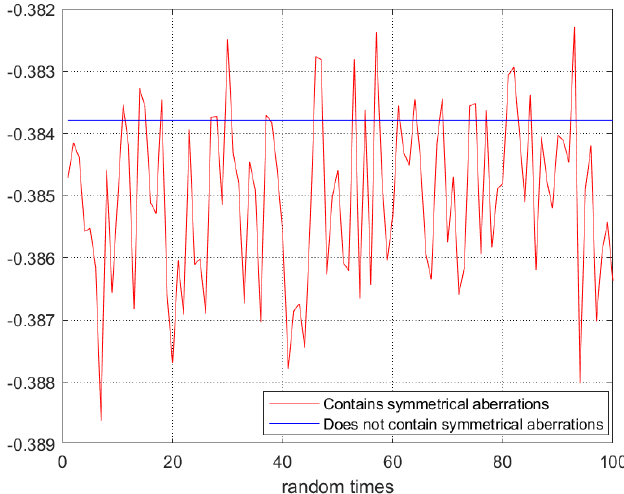
Figure 6. The effect of random aberration on phase demodulation with total aberration fixed at λ/60, blue does not contain rotational symmetry aberrations, and red does.